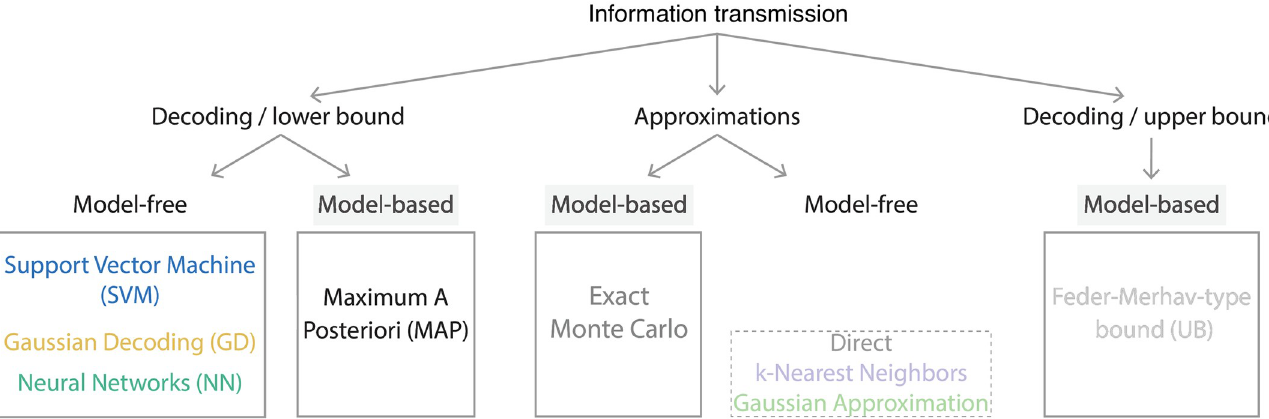
Fig 1. Information transmission between discrete inputs and response trajectories in biochemical networks. For fully-observed reaction networks whose dynamics are governed by a known chemical Master equation, information can be approximated to an arbitrary accuracy via Monte Carlo integration for either continuous-time or discrete-time response trajectories (model-based exact Monte Carlo , Section Exact information calculations for fully observed reaction networks ). Since full knowledge of the reaction system is used, these approximations are tractable deep in the regimes where model-free estimations break down with uncontrolled errors (Section Model–free information estimators ). True information estimates are lower-bounded by model-based maximum a posteriori (MAP) or Bayes optimal decoding (Section Decoding–based information bounds ). This decoding gives the lowest average probability of error and the corresponding information lower bound can be used as a benchmark for information estimates derived from other model-free decoding approaches (that have at least the error probability of the MAP decoder); in Section Decoding–based information estimators we compare Support Vector Machine (SVM), Gaussian Decoding (GD) and Neural Network (NN) decoding approaches. Upper bounds like the Feder-Merhav bound [34] and our improvement on it [35] complete the picture by estimating the gap between optimal decoding-derived and exact information values (Section Decoding–based information bounds ).